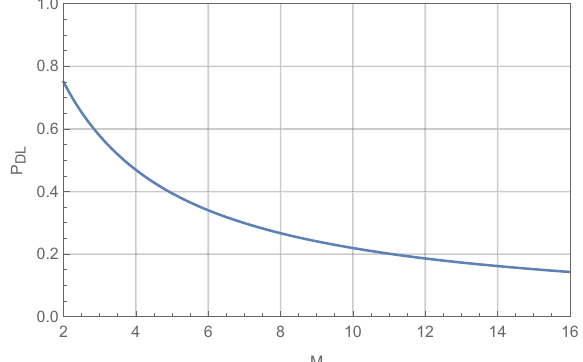
Fig. 5 Probability the photon goes to DL rather than D 0. This is the probability that, when the object does not block the photon ’ path, the photon travels via that path and so goes to DL rather than D 0. This is as a function of number of outer cycles ( M ).